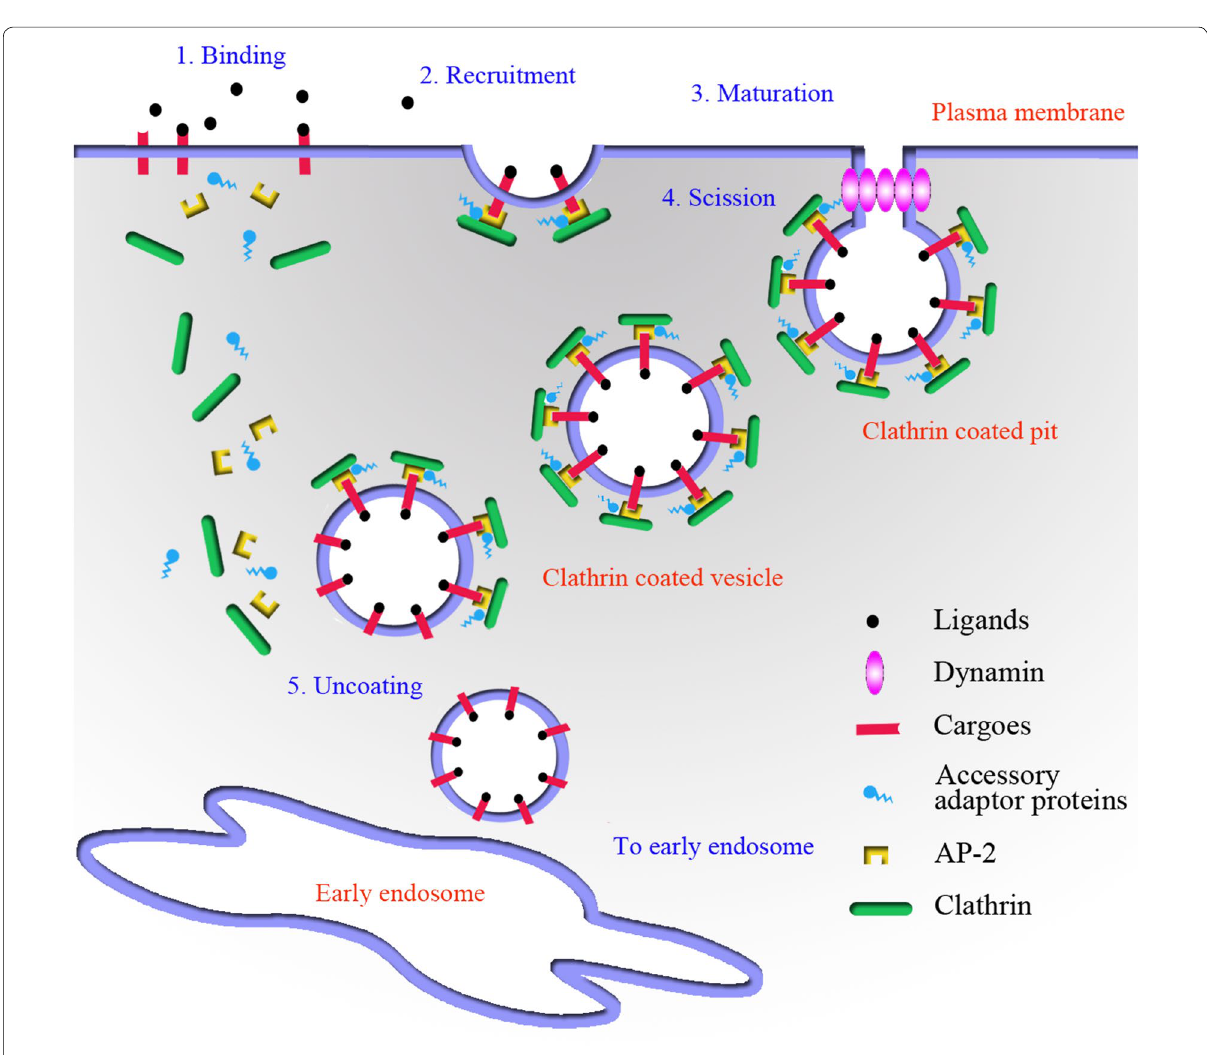
Fig. 5 Quantitative PCR analysis of the putative